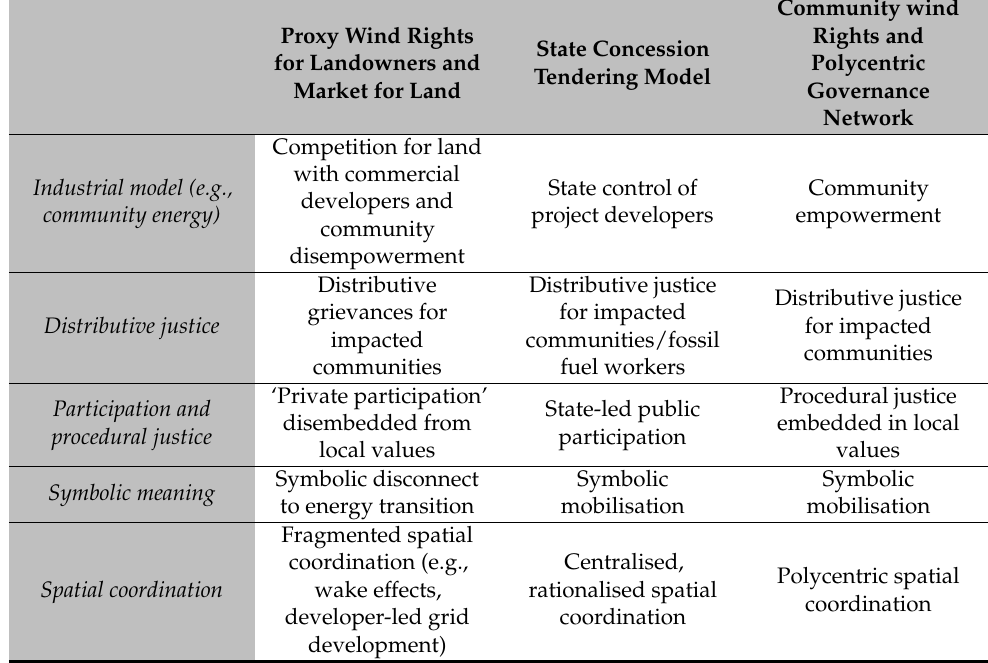
Table 3. Comparison of outcomes across three wind rights scenarios. Source: